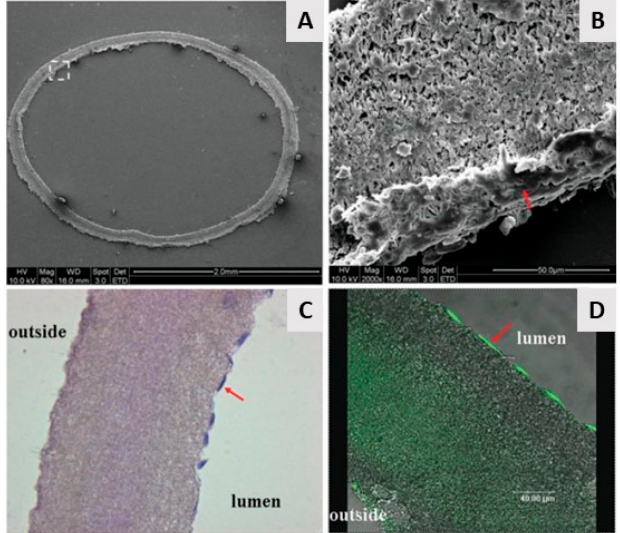
Figure 20. Visualization of the proliferation of HCAECs on plasma-modified tubular nanofibrous P(LLA-CL) conduits 10 days after cell culturing: ( A , B ) SEM micrographs of the cell-seeded scaffolds: ( A ) cross-section of the scaffold, ( B ) higher magnification image of the quadrangle shown in ( A ); ( C ) cross-section of the scaffold after H&E staining and ( D ) cross-section of the scaffold after immunostaining of PECAM-1. Original magnification: ( A ) 80 × , ( B ) 2000 × , ( C ) 200 × and ( D ) 630 × . Scale